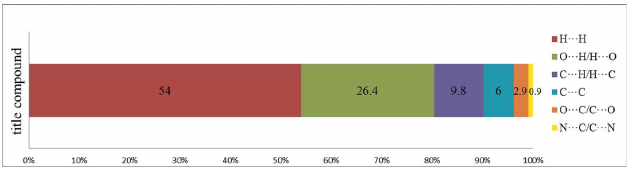
Figure 6 Percentage contributions of the various intermolecular contacts contri- buting to the Hirshfeld surfaces of the title